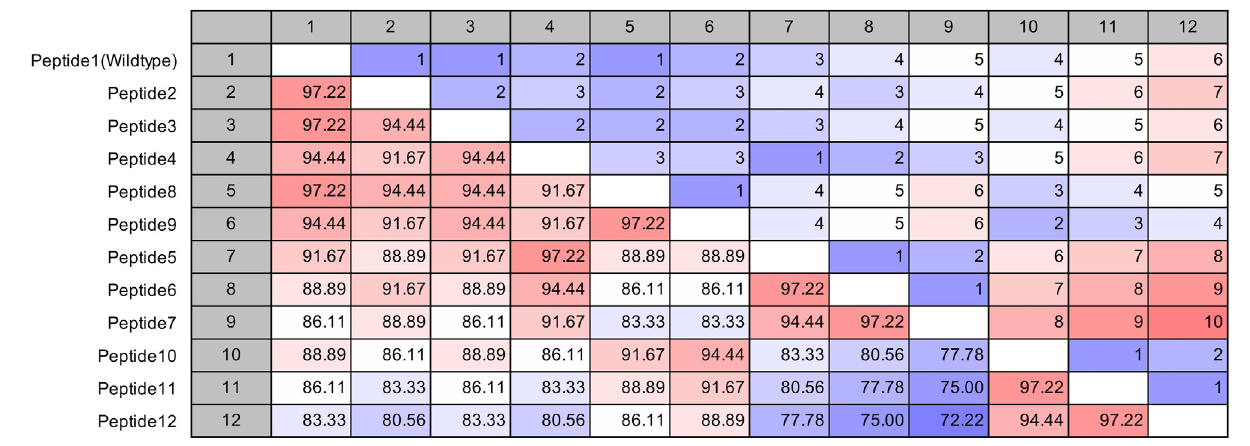
Frontiers in Pharmacology |